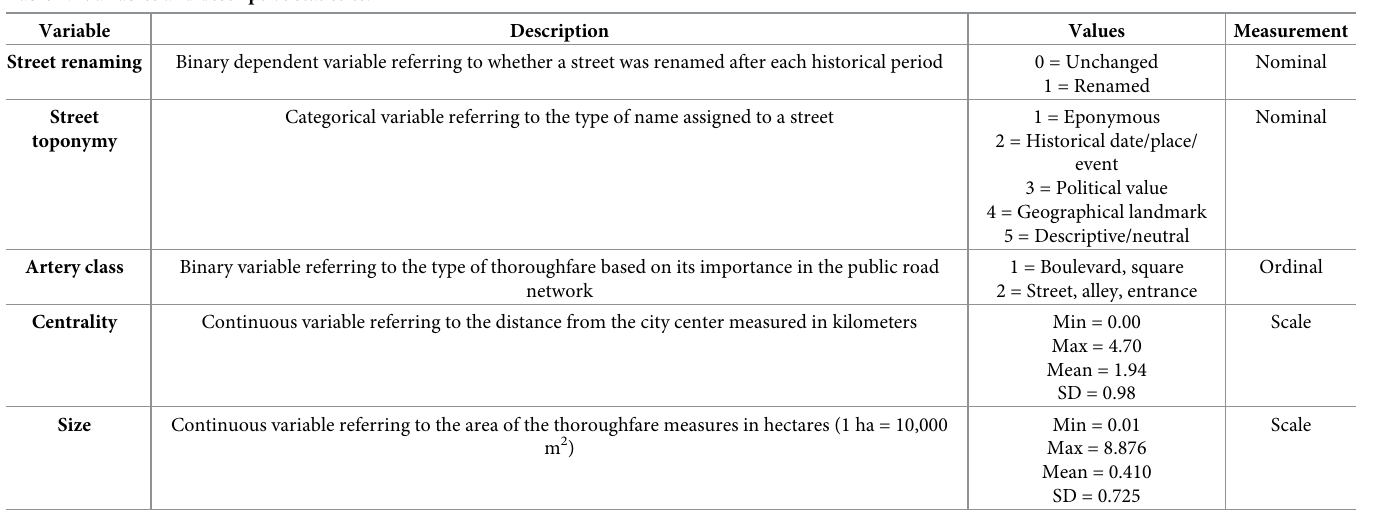
Table 4. Variables and descriptive